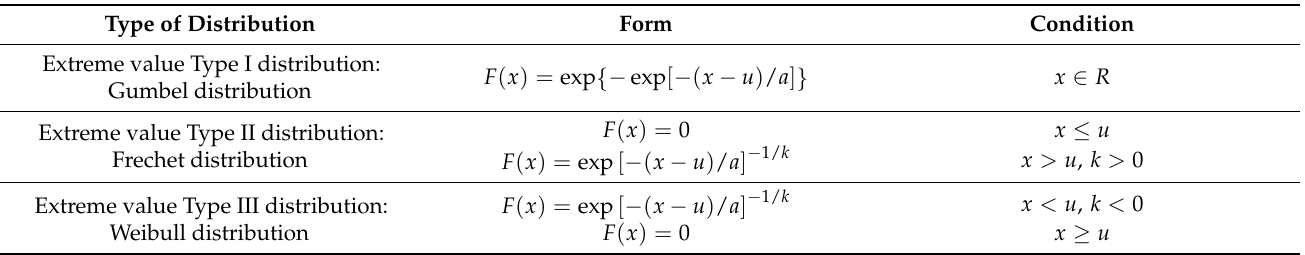
Table 1. Extreme value probability